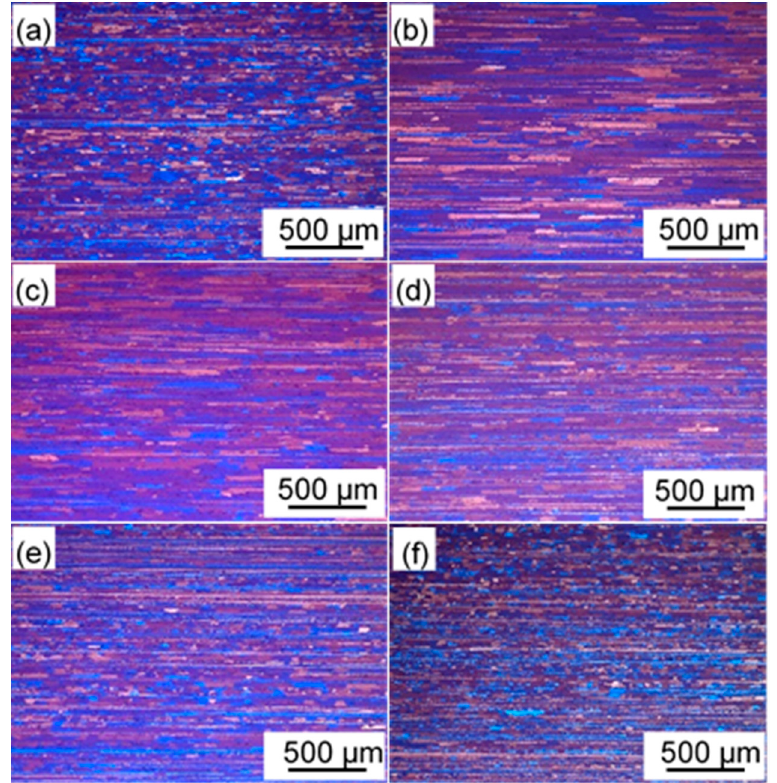
Figure 2. Longitudinal sectional metallographic pictures of solutionized samples after isothermal annealing at different temperature. ( a ) Direct solution; ( b ) 300 °C; ( c ) 325 °C; ( d ) 350 °C; ( e ) 375 °C; and ( f ) 400 °C.